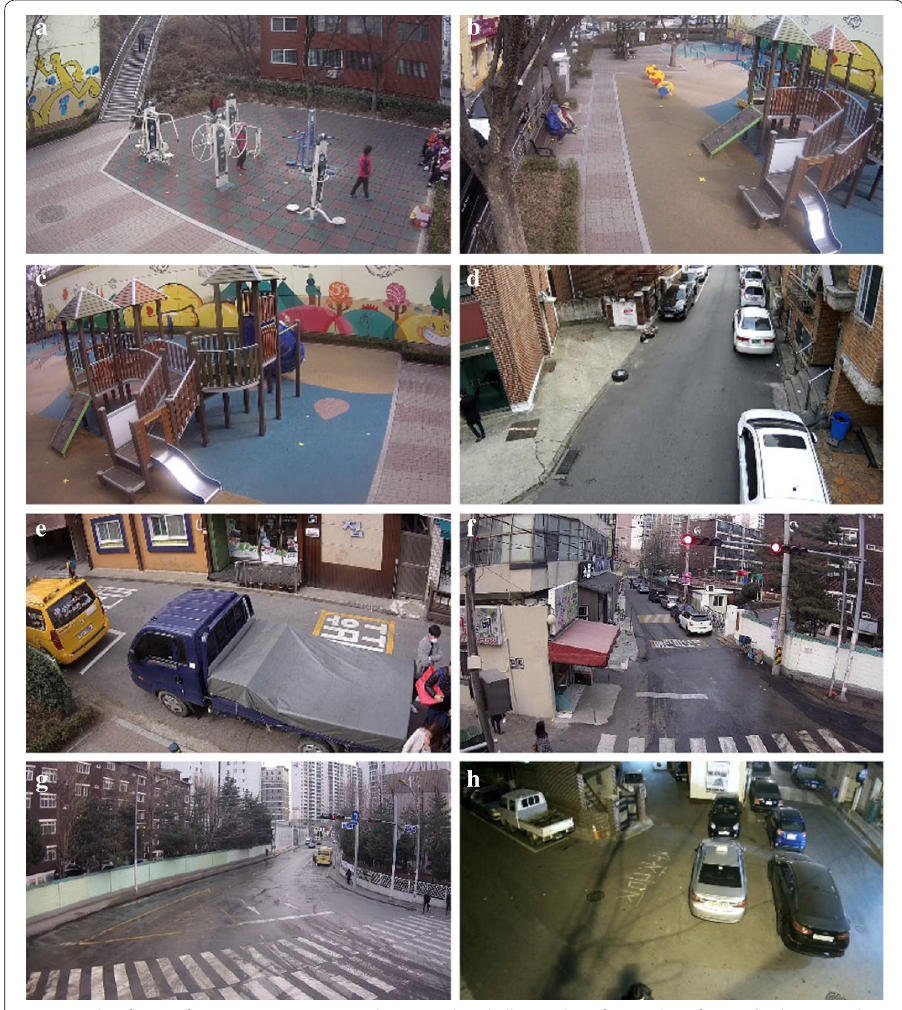
Fig. 4 Video frames from CCTV cameras in playground and alley. a Place for outdoor fitness. b